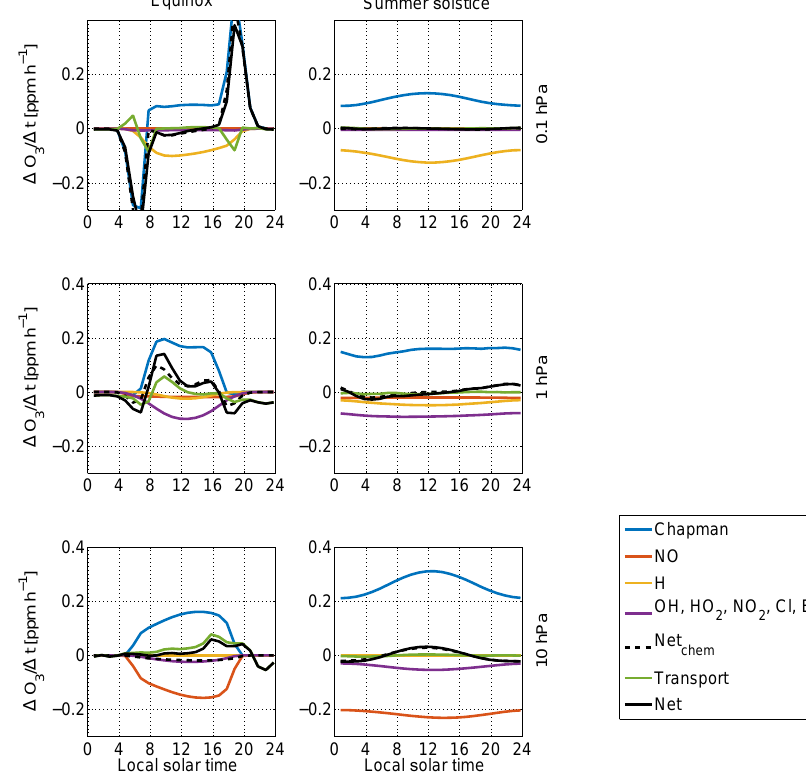
Figure 14. Reaction rates of ozone production and loss from SD-WACCM at Ny-Ålesund. The reaction rates are averaged over 10 days around equinox and over 42 days around summer solstice of the year 2016 and are shown for three pressure levels. The dashed black line shows the net chemical production rate, and the black solid line shows the net production rate including transport.